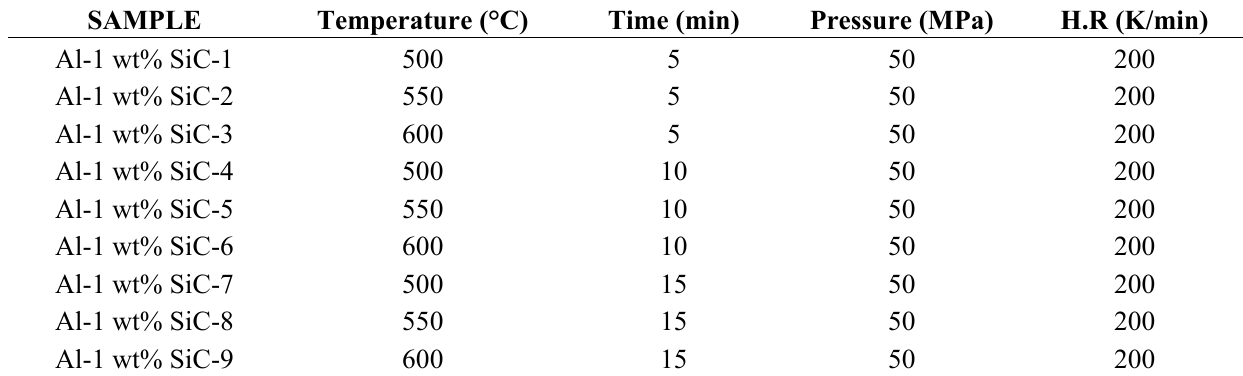
Table 2. Experimental parameters used to investigate the influence of sintering temperature and